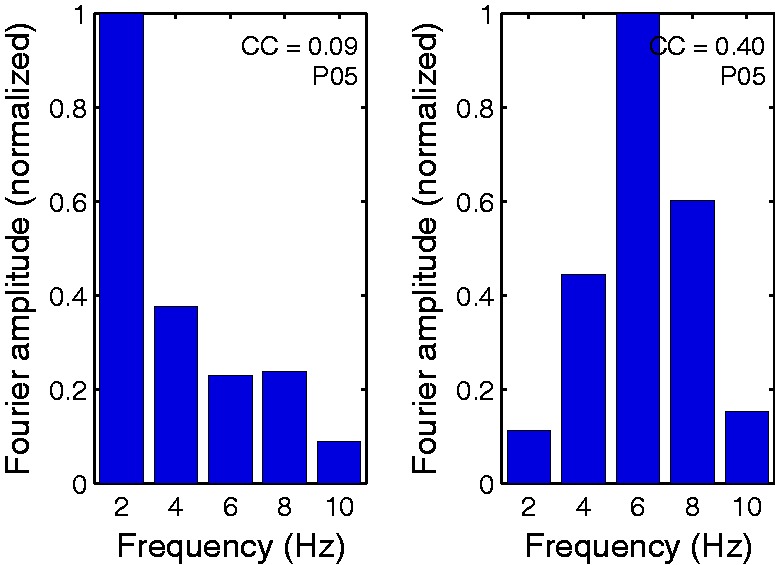
Normalized Fourier amplitude spectrum of checkerboard responses for two different
RMS cone contrasts (0.09 on the left and 0.4 on the right) for a typical
participant.